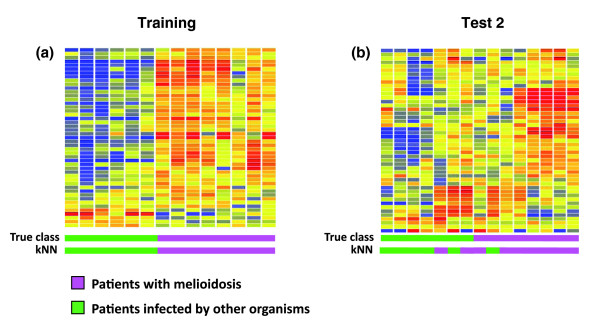
Candidate blood transcriptional markers retain their discriminatory power in an additional secondary validation set. (a) Patients with sepsis clustered in region R5 of the training set (comprising eight patients with melioidosis (pink rectangles) and six patients with sepsis caused by other organisms (green rectangles) were hybridized to Illumina Human HT-12 V3 BeadChips and used for microarray analysis as before. The 37 blood transcriptional markers identified from the same samples using Illumina Human V2 BeadChips were used for class prediction analysis of the new dataset in a leave-one-out cross-validation scheme as before. The 37 classifiers discriminated training set samples analyzed using the novel data with 100% accuracy as before, despite the change of microarray platform. (b) The performance of the 37 predictor genes was then further evaluated in a secondary independent test set also analyzed using Illumina Human HT-12 V3 BeadChips. This second independent test set (n = 15) comprised eight patients with melioidosis (pink rectangles) and seven patients with sepsis caused by other organisms (green rectangles). The predictors correctly classified 12 of the 15 samples (80% accuracy).